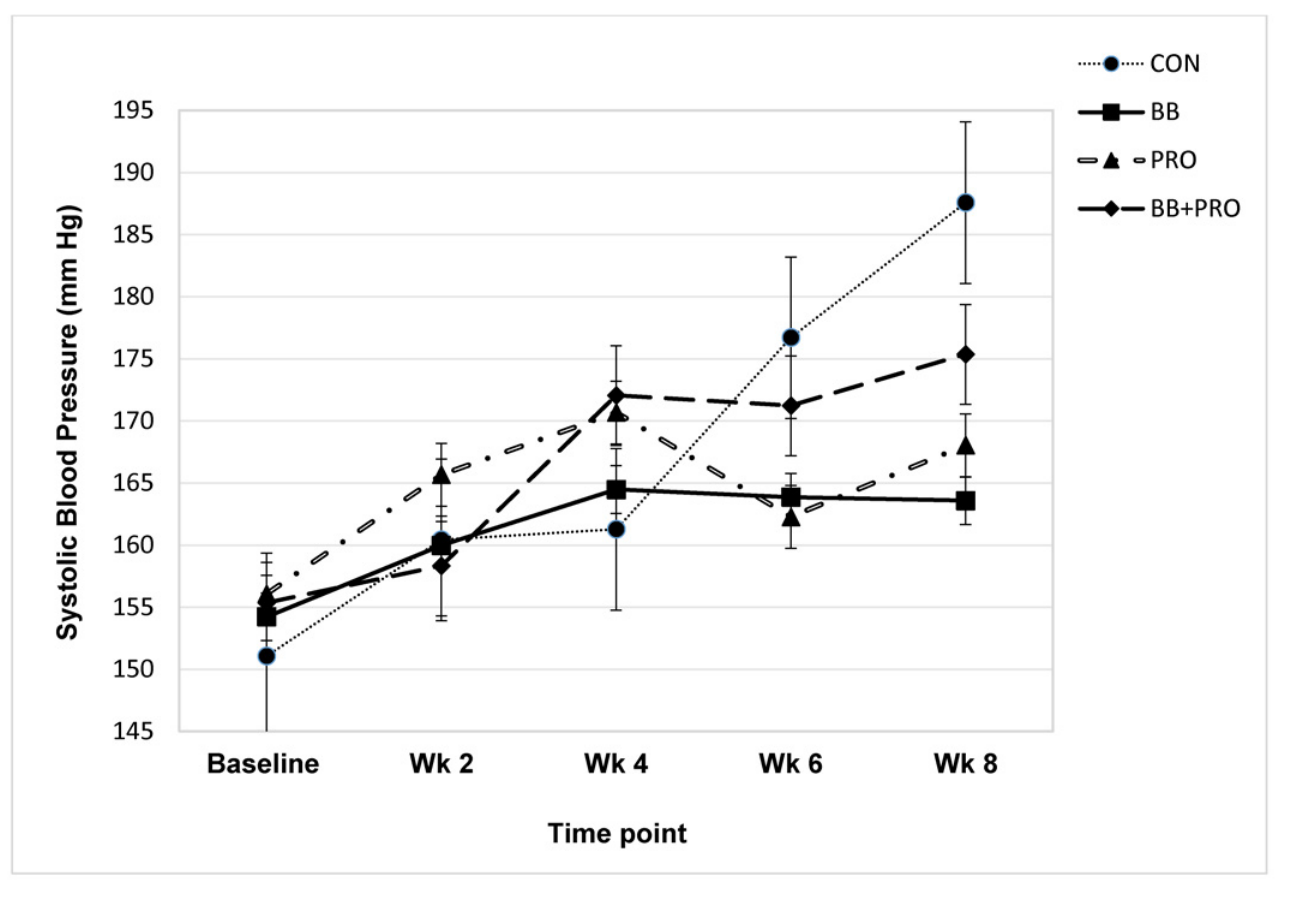
Fig 2. Systolic blood pressure. Systolic blood pressure of spontaneously hypertensive rats fed control (CON), 3% blueberry (BB), 1% probiotic (PRO), or 3% blueberry + 1% probiotic (BB+PRO) diet for 8 weeks. Data points are presented as means ± SEM for 8 rats in each diet group, with statistical analysis performed by mixed models ANOVA with repeated measures. Diet did not exert a significant main effect on systolic blood pressure across time points ( p = 0.220) (S2 Dataset). doi:10.1371/journal.pone.0142036.g002 PLOS ONE | DOI:10.1371/journal.pone.0142036 November 6,